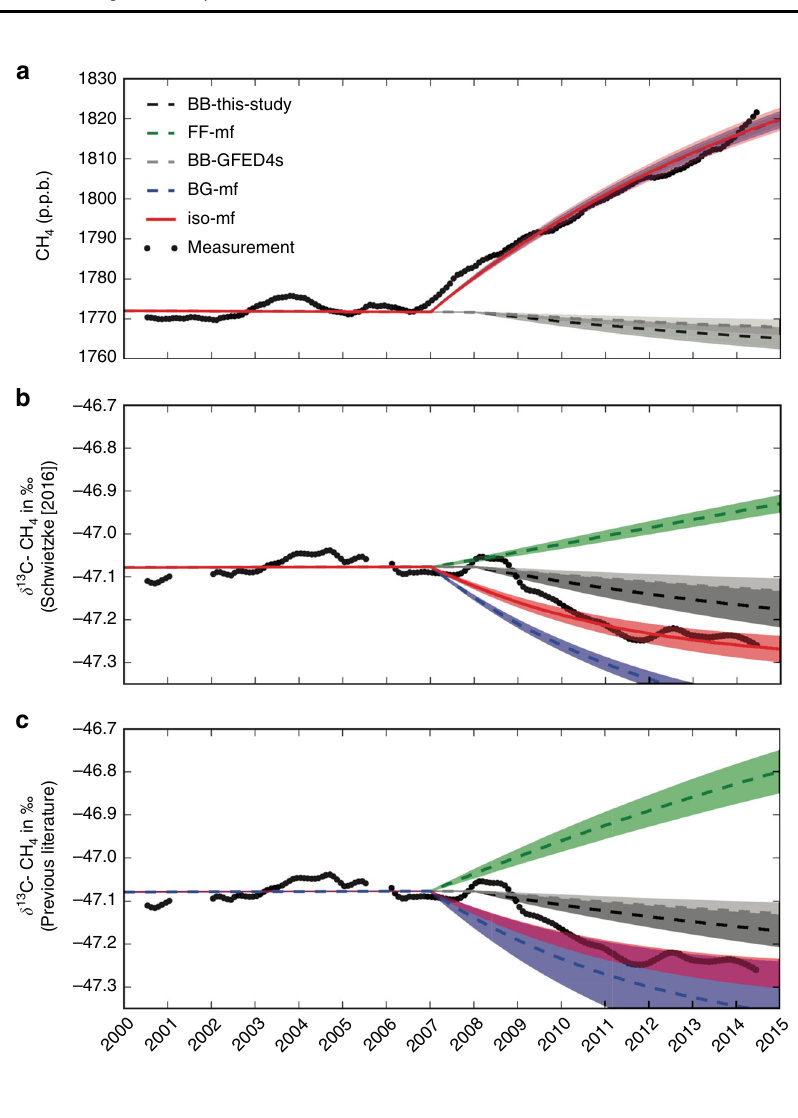
Fig. 3 Simulated CH 4 and δ 13 C-CH 4 values. CH 4 mixing ratios ( a ) and simulated by the box model for values shown in Table 1 and listed by model scenario in Table 2. b , c describe the simulated δ 13 C-CH 4 using the updated values from Schwietzke et al. 15 and from prior literature. The biomass burning changes are prescribed based on the estimates from this study (BB-this-study) and GFED4s (BB-GFED4s). For the BG-mf and FF-mf scenarios, the CH 4 mole fractions growth is explained by an emission increase of only biogenic or only fossil fuel, respectively (BG-mf and FF-mf overlap in a ). The iso-mf scenario shows the best fi t to the isotope and mole fraction data, using an additional source of 24.7 ± 1.4 Tg CH 4 per year with an isotopic signature of − 56.1 ± 1.1 ‰ . The required adjustments to the methane budgets for fossil fuel and biogenic sources are shown in Figs. 4 and 5. The 1-sigma error margins are the propagated uncertainties of isotopic source signatures and uncertainties of the perturbations. The measurements shown here are the calculated global average of NOAA-ESRL network